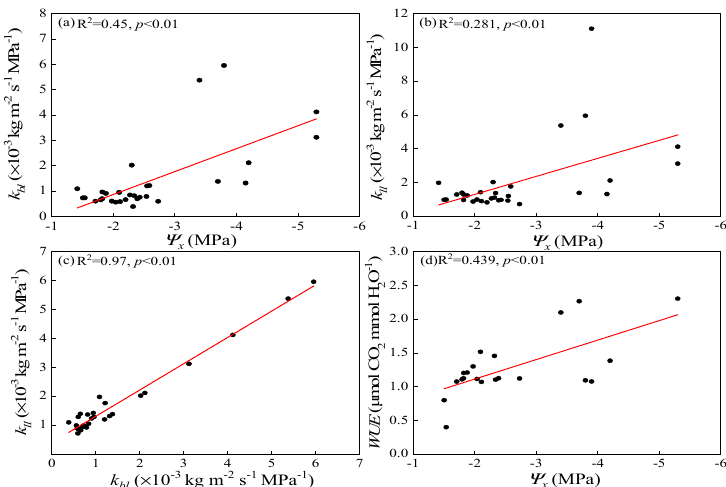
Figure 7. Regression analysis for dehydration treatments: ( a ) twig water potential ( Ψ x ) and LSC of leafy branches ( k bl ), ( b ) twig water potential ( Ψ x ) and LSC of leaf blades ( k ll ), ( c ) LSC of leafy branches ( k bl ) and LSC of leaf blades ( k ll ), and ( d ) twig water potential ( Ψ x ) and water use efficiency (WUE). All regressions shown were highly significant ( p < 0.01).